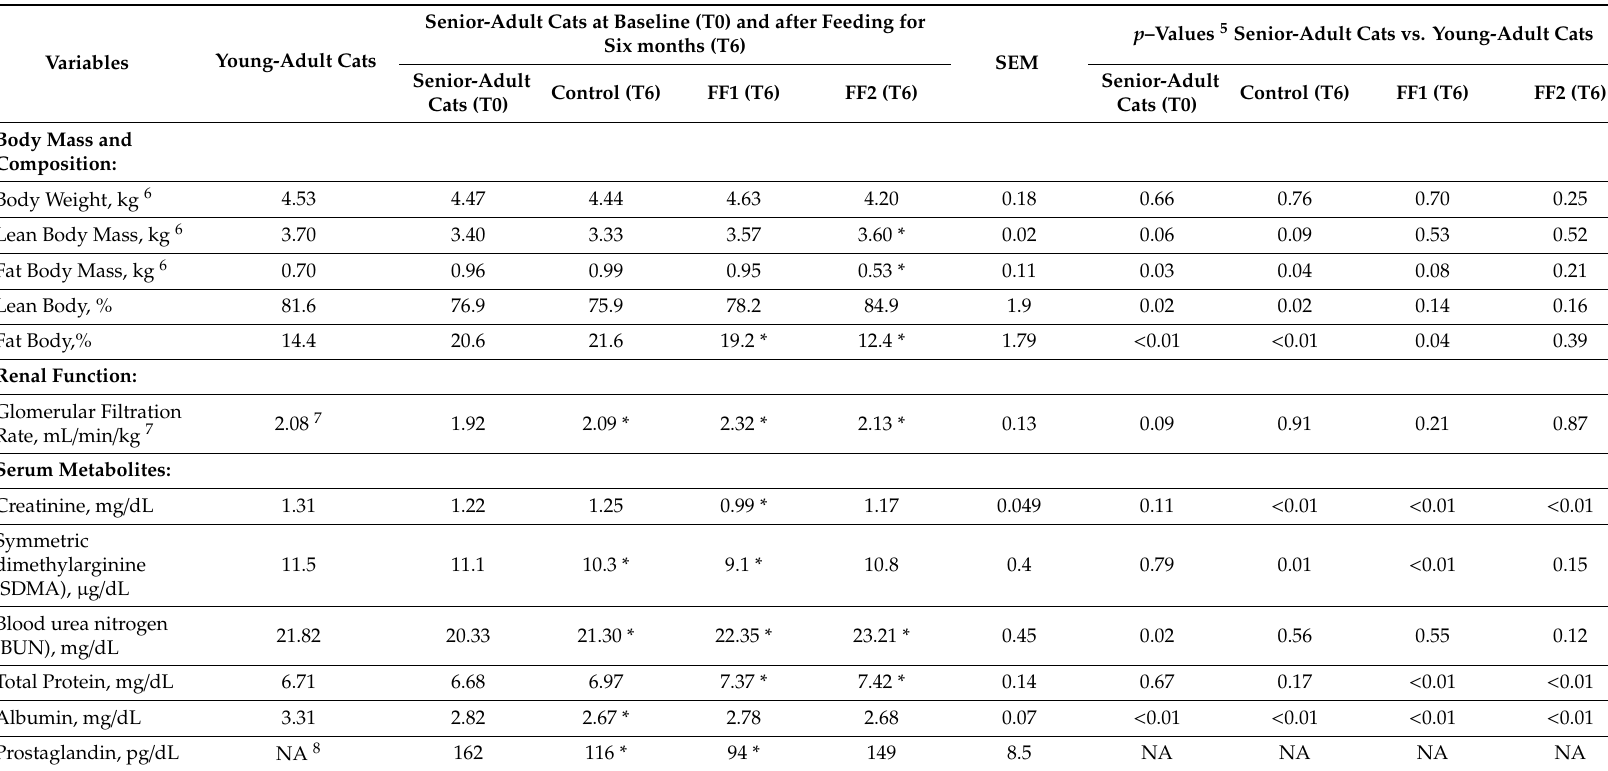
Table 3. E ff ect of feeding control 1 or two functional foods (FF1 and FF2) 2 for six months (T6) on body composition, renal function, and serum metabolite concentrations in senior-adult cats 3 (least square mean, LSM ± standard error of the mean, SEM) compared with their baseline values (T0), and values for young-adult cats 4 (LSM).